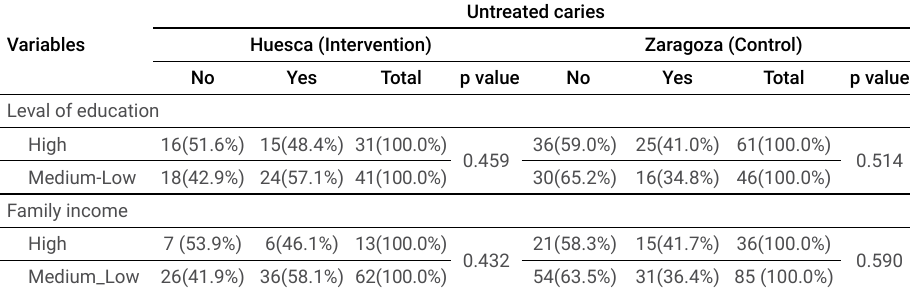
Table 3. Bivariate analysis for 7 to 11-year-olds per city in the IDEFICS study in Spain, for untreated